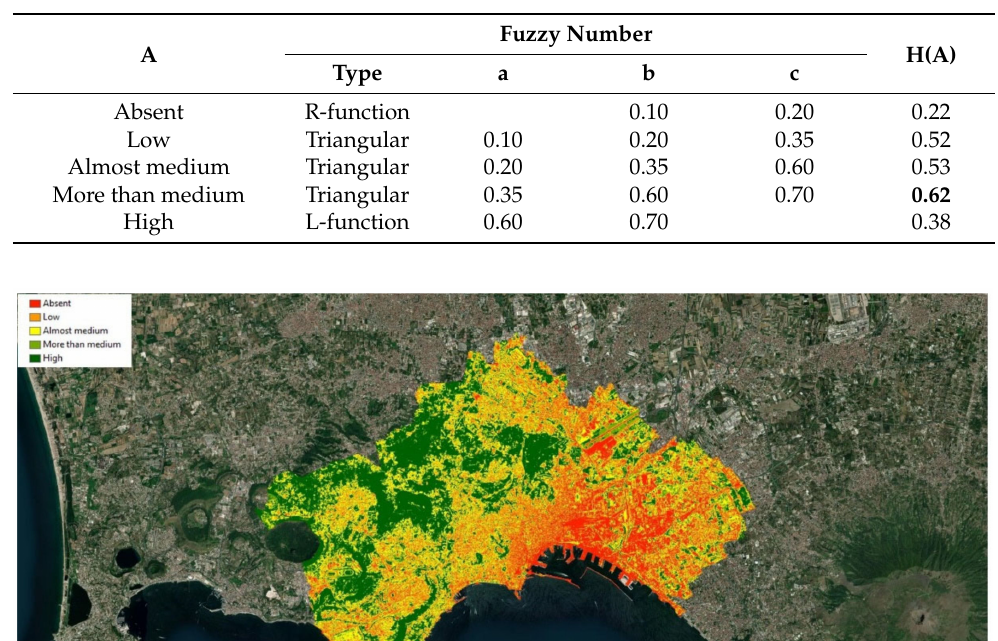
Table 7. Fuzzy sets of the fuzzy partition in Figure 14 and their fuzziness.